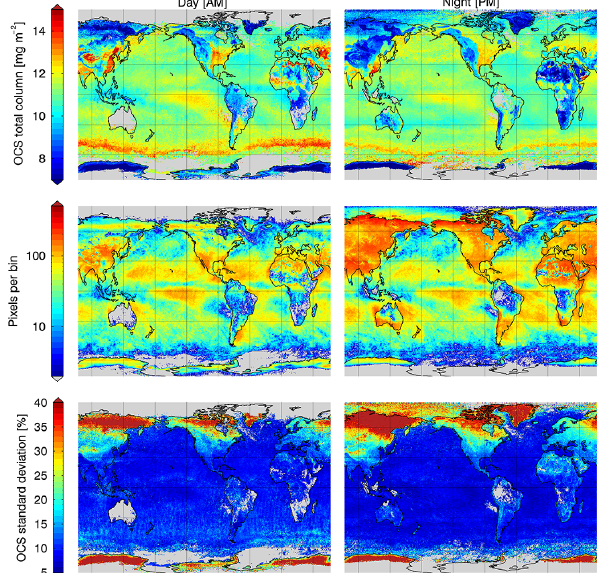
Figure 16. Same as in Fig. 10, but for all of 2014